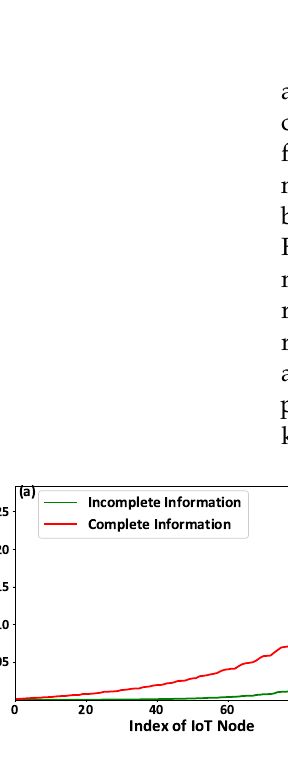
Figure 2. IoT nodes’ ( a ) invested effort, ( b ) gained reward, and ( c ) achieved utility under the proposed contract-theoretic energy harvesting framework—Complete versus Incomplete information scenarios.